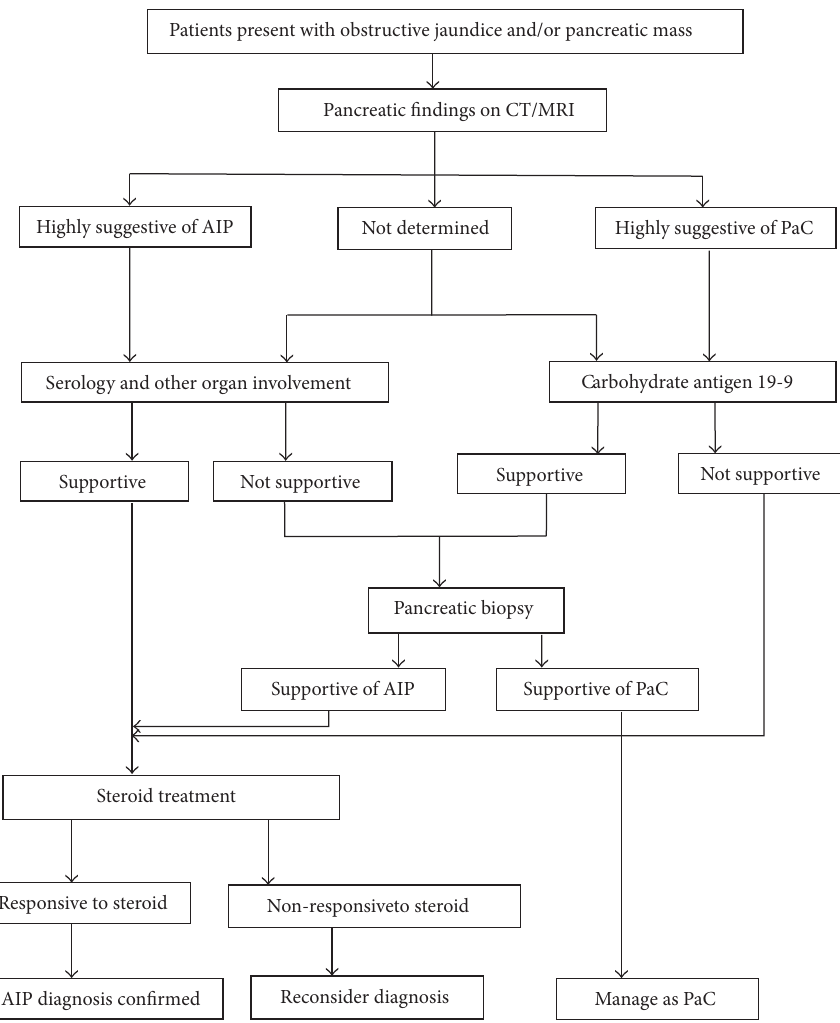
Figure 1: Strategy for distinguishing AIP from pancreatic cancer [14]. CT: computed tomography; MRI: magnetic resonance imaging; PaC: pancreatic cancer; OOI/O: other organ involvement; S: serology; CA19-9: carbohydrate antigen